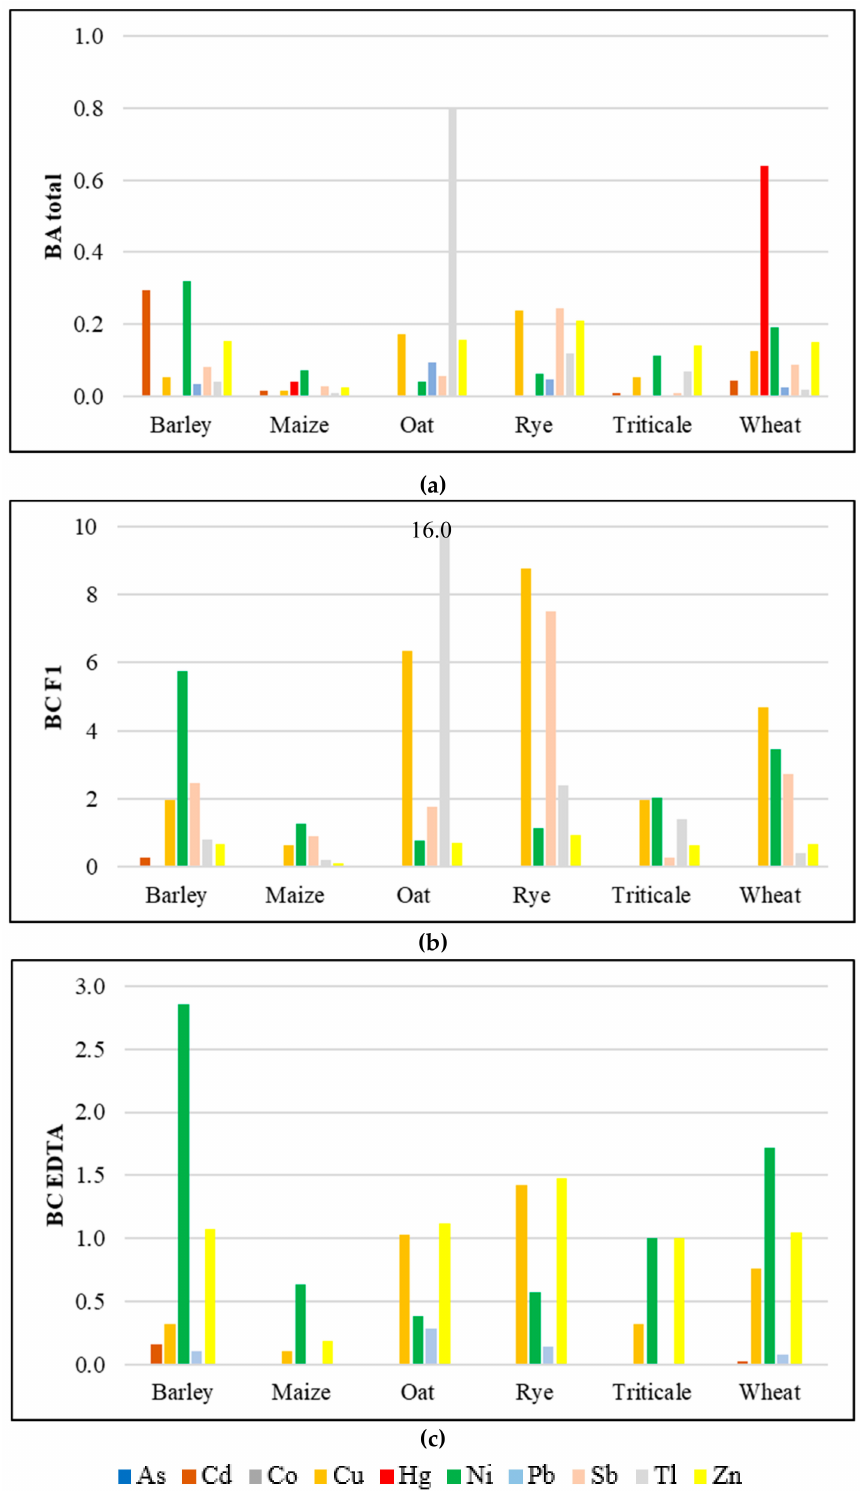
Figure2. Soil-to-planttransferindicesfortheinvestigatedgroupsofcereals: ( a )BA total —bioaccumulation coefficient, total PHE content; ( b ) BC F1 —bioconcentration coe ffi cient, PHE content of the F1 fraction